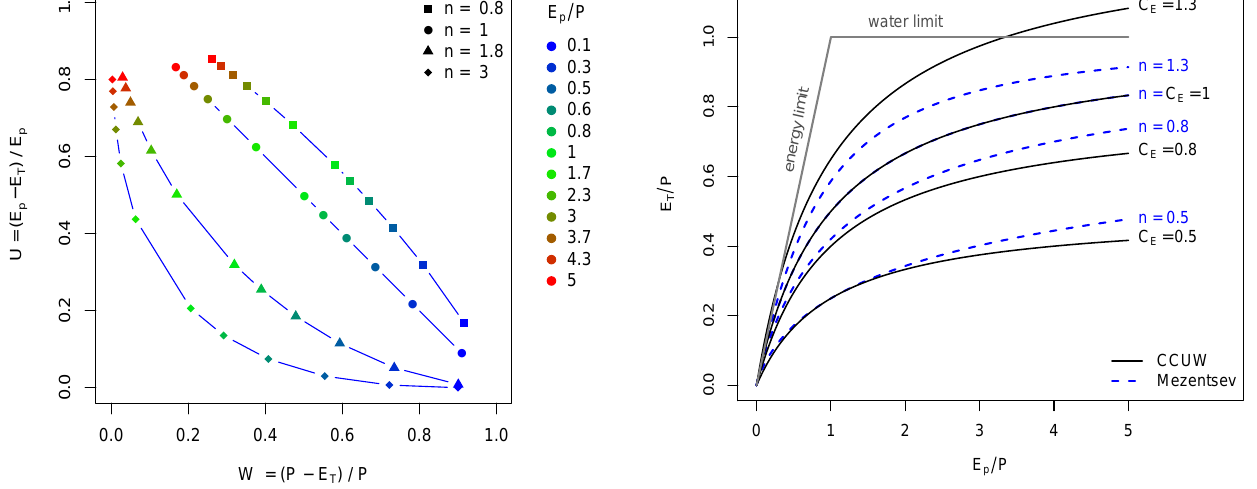
Fig. 2. Mapping different parameterised Mezentsev functions into UW space using Eq. (25). The colours depict certain aridity ( E p /P ) values indicated by the legend in the right.